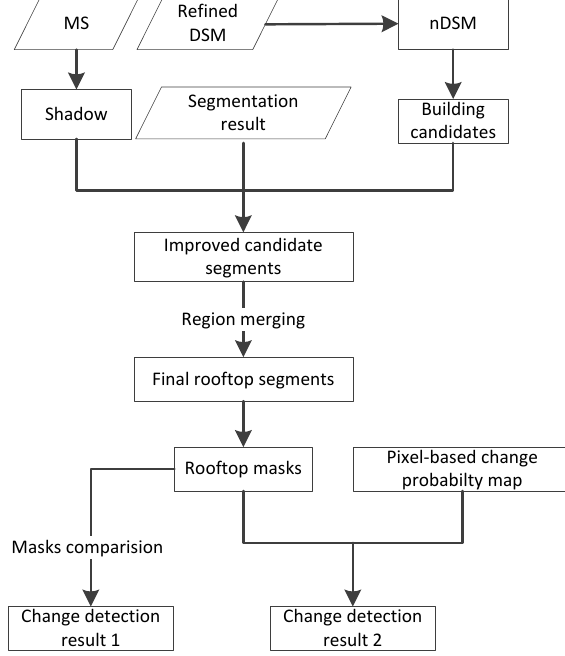
Figure 5. Workflow of rooftop extraction and change detection.